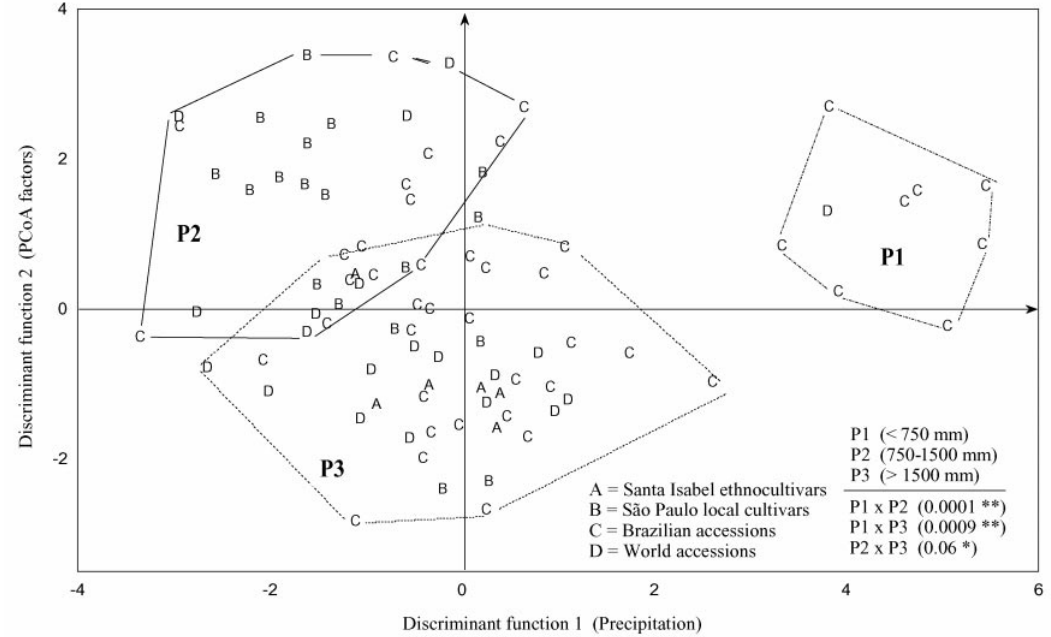
Figure 5 - Scattering of 90 cassava cultivars on a plot defined by discriminant function 1, based on precipitation (P1 to P3) of cultivar’s place of origin, and discriminant function 2, based on the first 40 principal coordinate analysis (PcoA) factors. *,**Statistically significant at 5% and 1%,